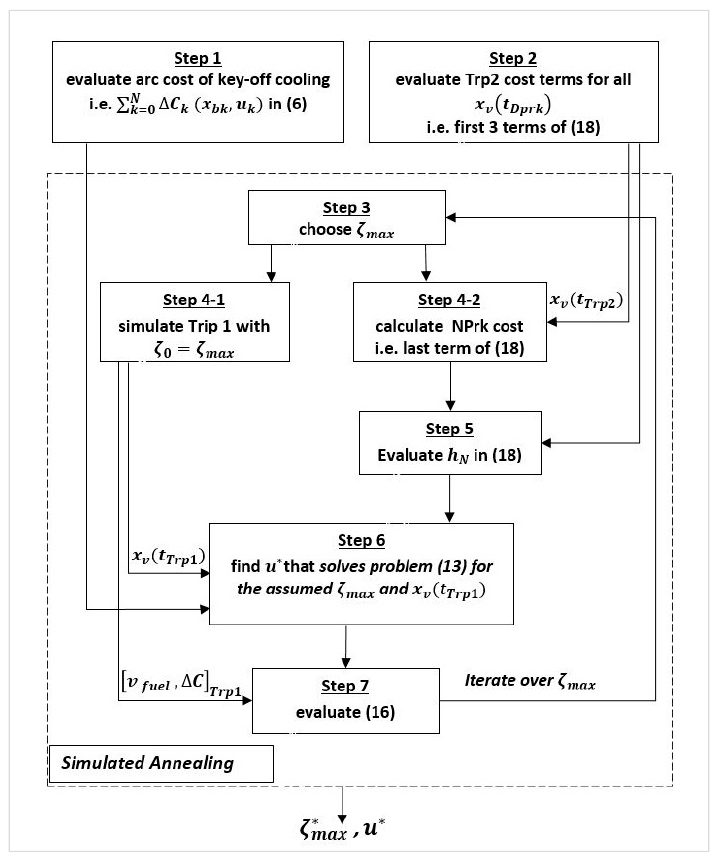
Figure 11. Flow chart of the process used for solving the problem defined by (16).